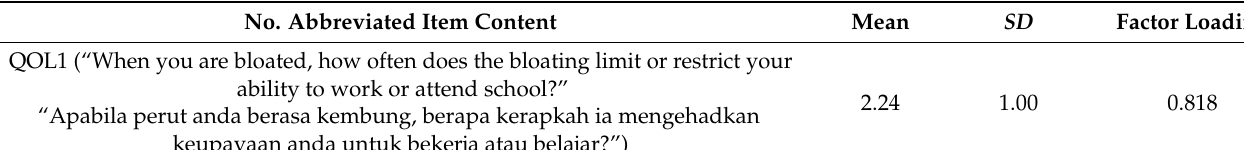
For the QoL part (BLQoL-M), the means and SDs for each item are summarized in Table 2. The internal consistency of one domain of QoL was good (Cronbach’s α = 0.81). All items exceeded the cut point of 0.4 suggested good factor loadings. As such, all items were retained as the original five-item scale. Principle axis factoring EFA with Promax rotation produced one subscale scores for all five items with an eigenvalue of 2.94 and measured symptom impact to quality of life that accounted for 58.79% of the variance in BLQoL-M score. Table 2. Descriptive statistics for quality of life domain ( n =